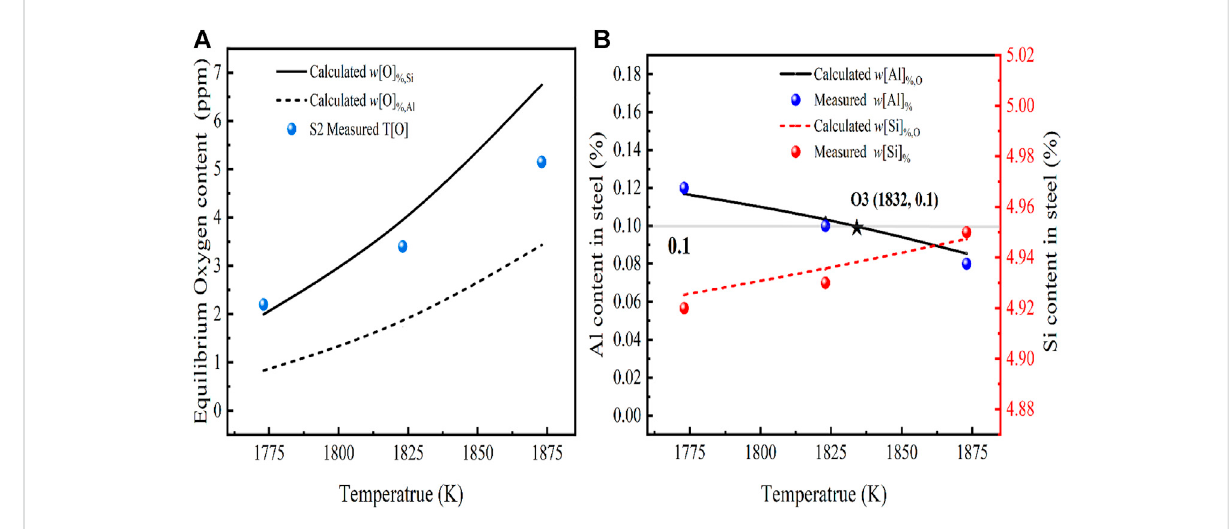
FIGURE 9 Effect of temperature on (A) oxygen, (B) silicon and aluminium content in steel (model predictions (lines) and experimental-data